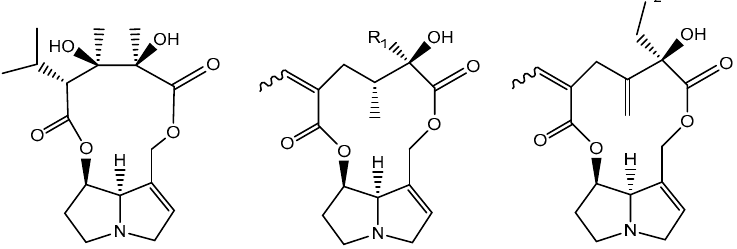
Figure 6. Chemical structure of tricodesmine, senecionine (R 1 = H)/retrorsine (R 1 = OH) and